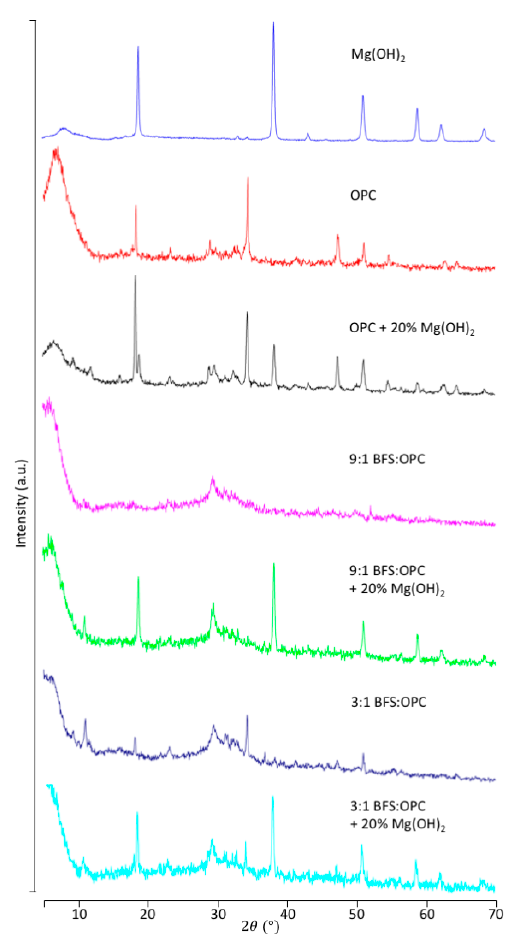
Figure 2. XRD patterns of Mg(OH) 2, with OPC, 3:1 BFS/OPC, and 9:1 BFS/OPC with and without 20 wt % Mg(OH) 2 . No phases from reaction of Mg(OH) 2 with cement samples can be identified in the patterns. Ancillary XRD patterns are supplied in the Supplementary Materials Figure